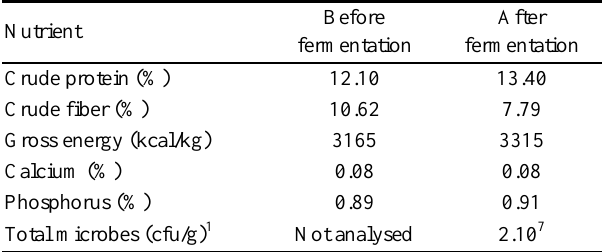
Table 3. Chemical composition and total microbes of rice bran before and after fermentation